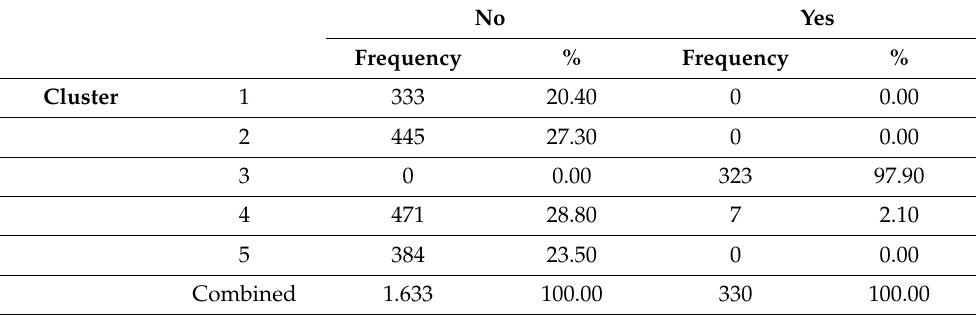
Table 8. Do you own a prepaid time ticket for public